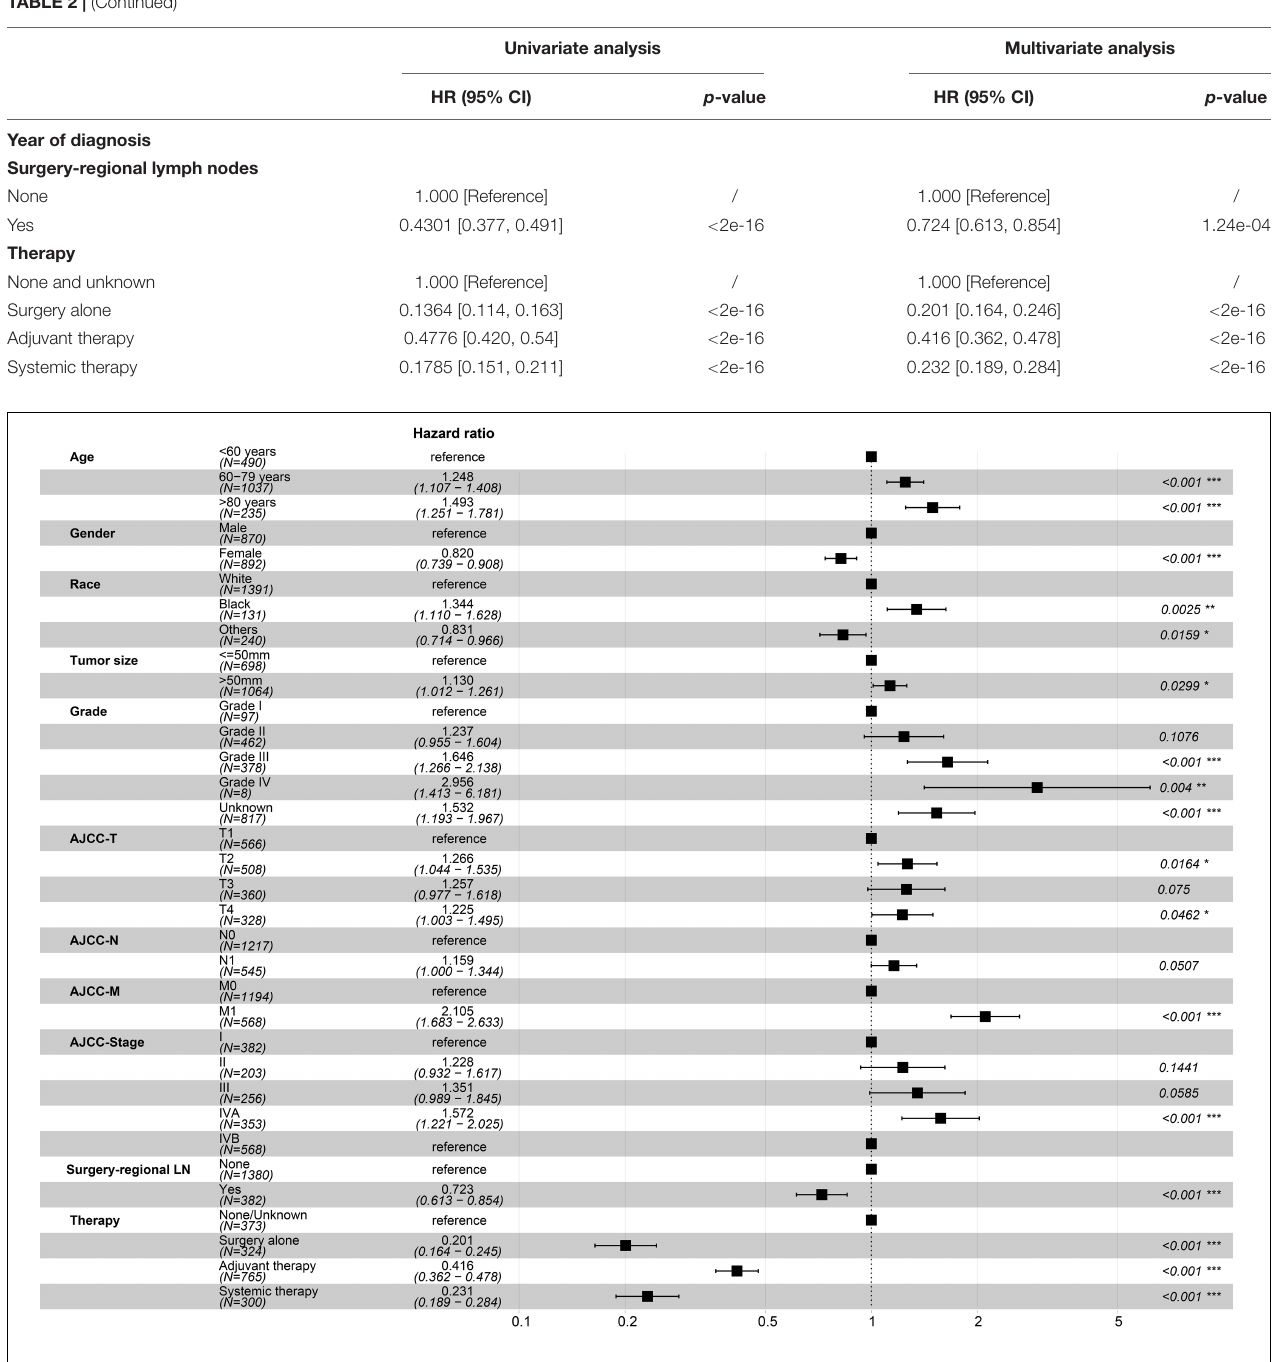
FIGURE 6 | Forest map in the multivariate prognostic